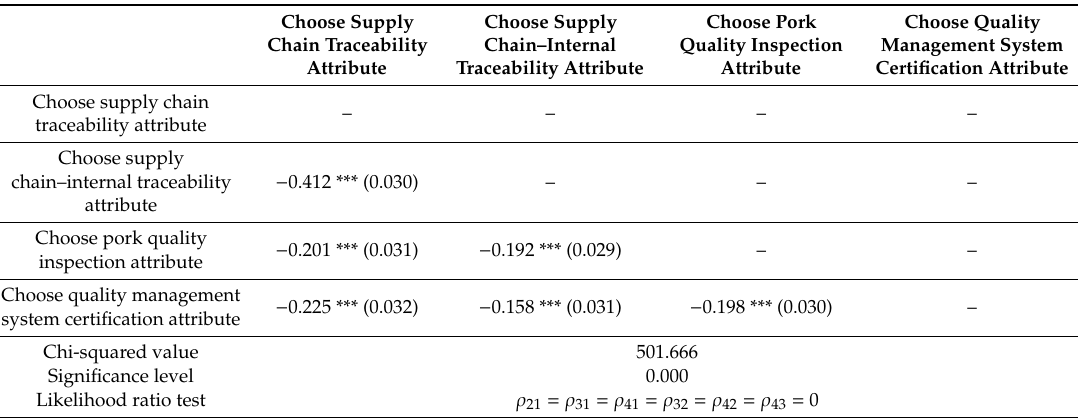
Table 9. The covariance matrix of the multivariate probit model.